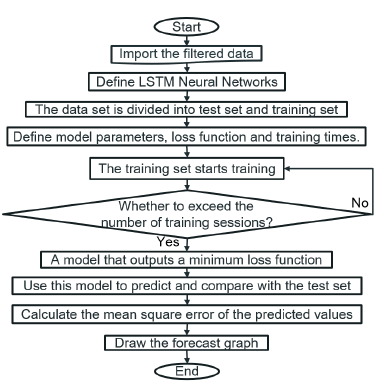
Figure 10. The code process of building the LSTM